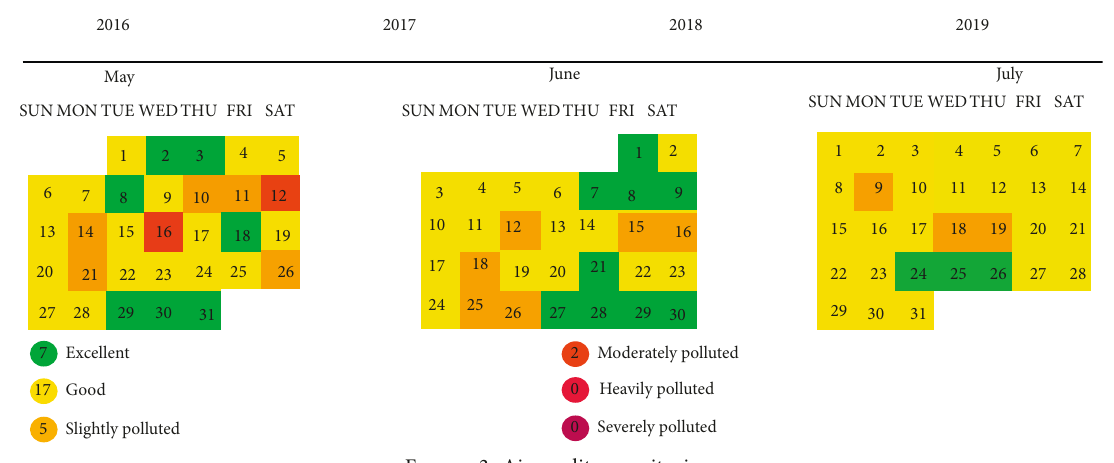
Figure 3: Air quality monitoring. Table 1: Air quality standard based on ambient air quality index